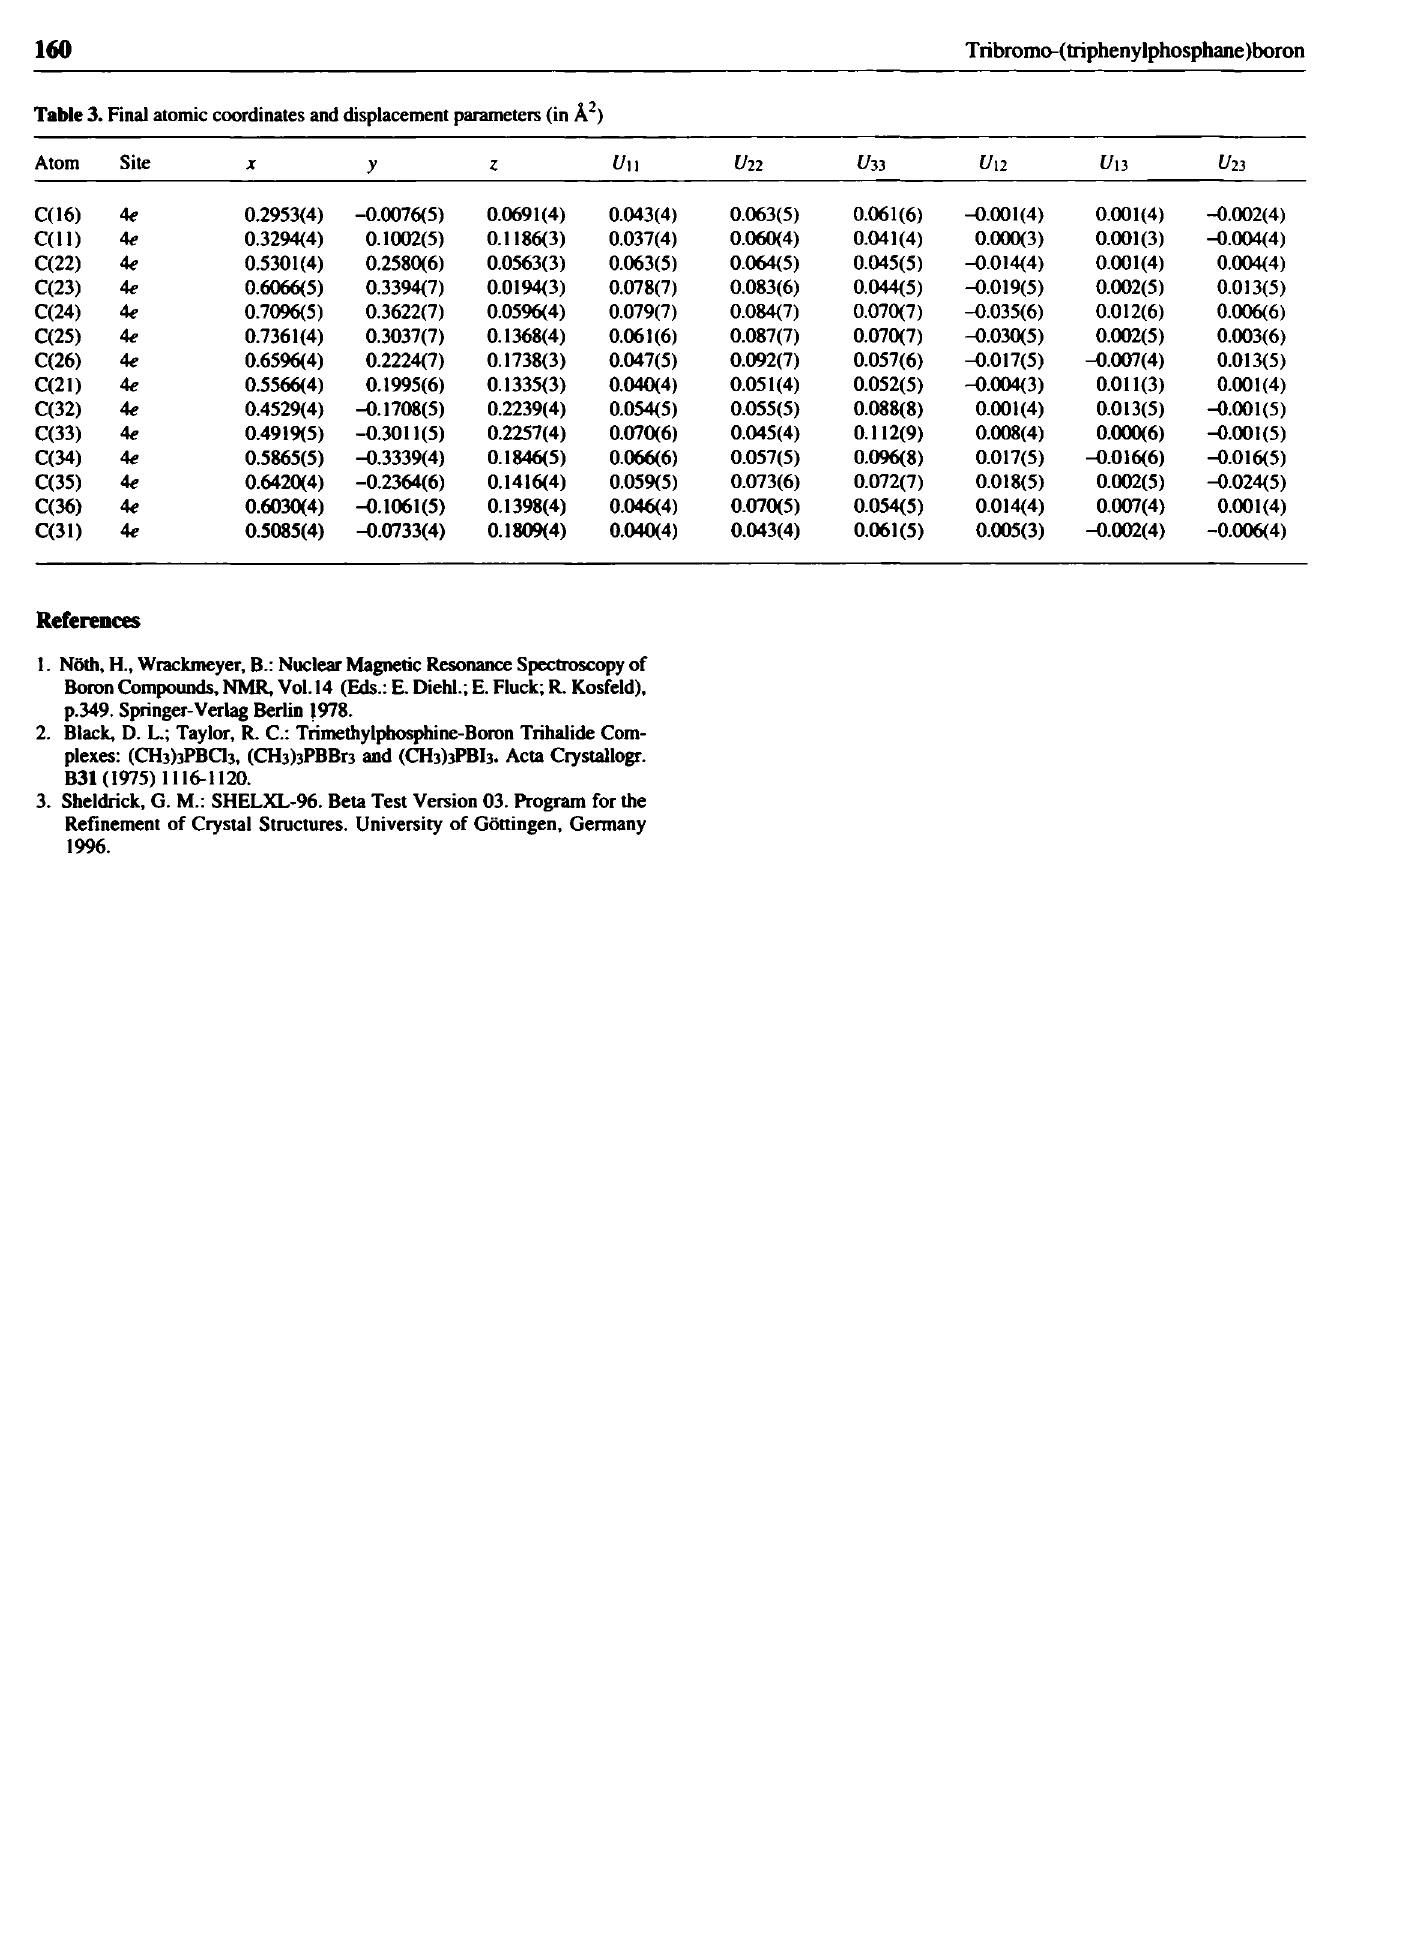
Table 3. Final atomic coordinates and displacement parameters (in Â 2